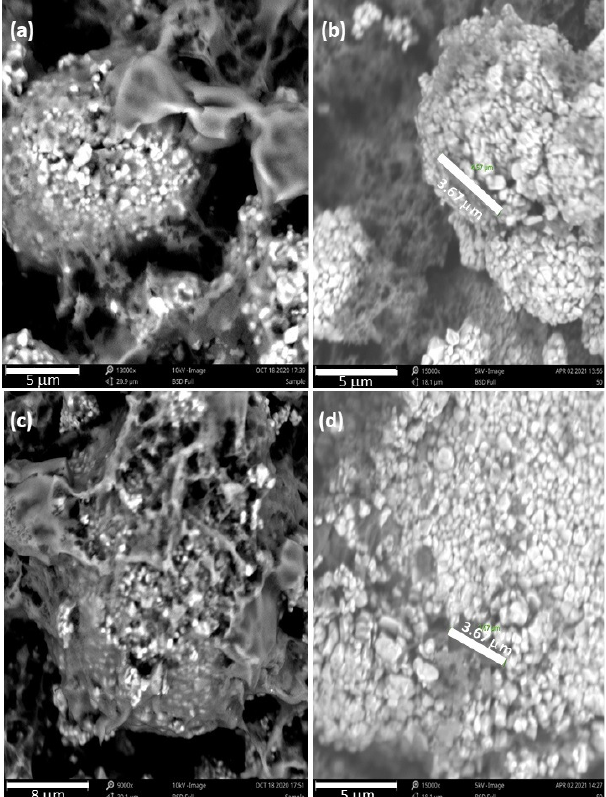
Figure 7. SEM images of pristine NMC811 and rGO/NMC811 cathode material after cycling the batteries for 100 cycles over the high-voltage operating window of 2.5–4.5 V. ( a ) Image showing pristine NMC811 after 100 cycles. Microcracks and missing NMC811 granules can be observed. ( b ) An expanded view of rGO/NMC811 material after 100 cycles. ( c ) A close-up view of the NMC811 material after 100 cycles. ( d ) A close-up view of rGO/NMC811 after 100 cycles. The amount of rGO additive used was 5wt% of the composite rGO/NMC811 cathode